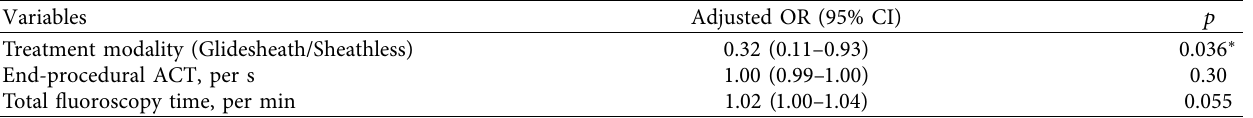
Table 5: Multivariate logistic regression analysis to determine predictors of radial artery occlusion at 30 days.